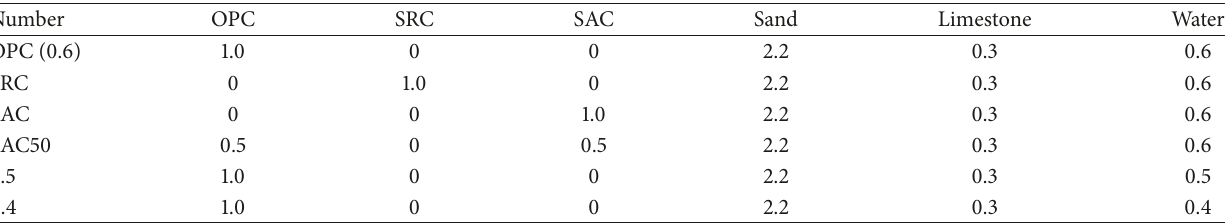
Table 2: Mixing proportions of